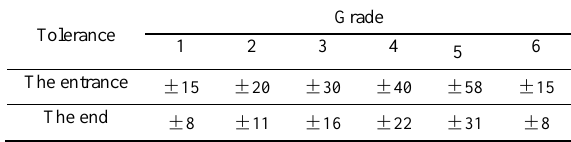
Table 2. Tolerance in axis Y for the cover box (µm) Tolerance